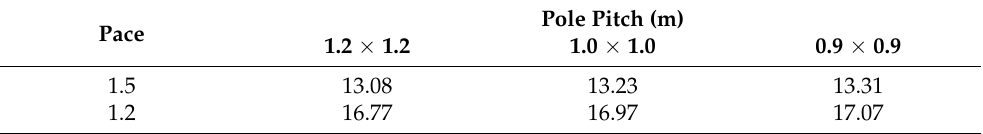
Table 6. Based on the theory of semirigid frame with lateral displacement, the stable bearing capacity of vertical bar is